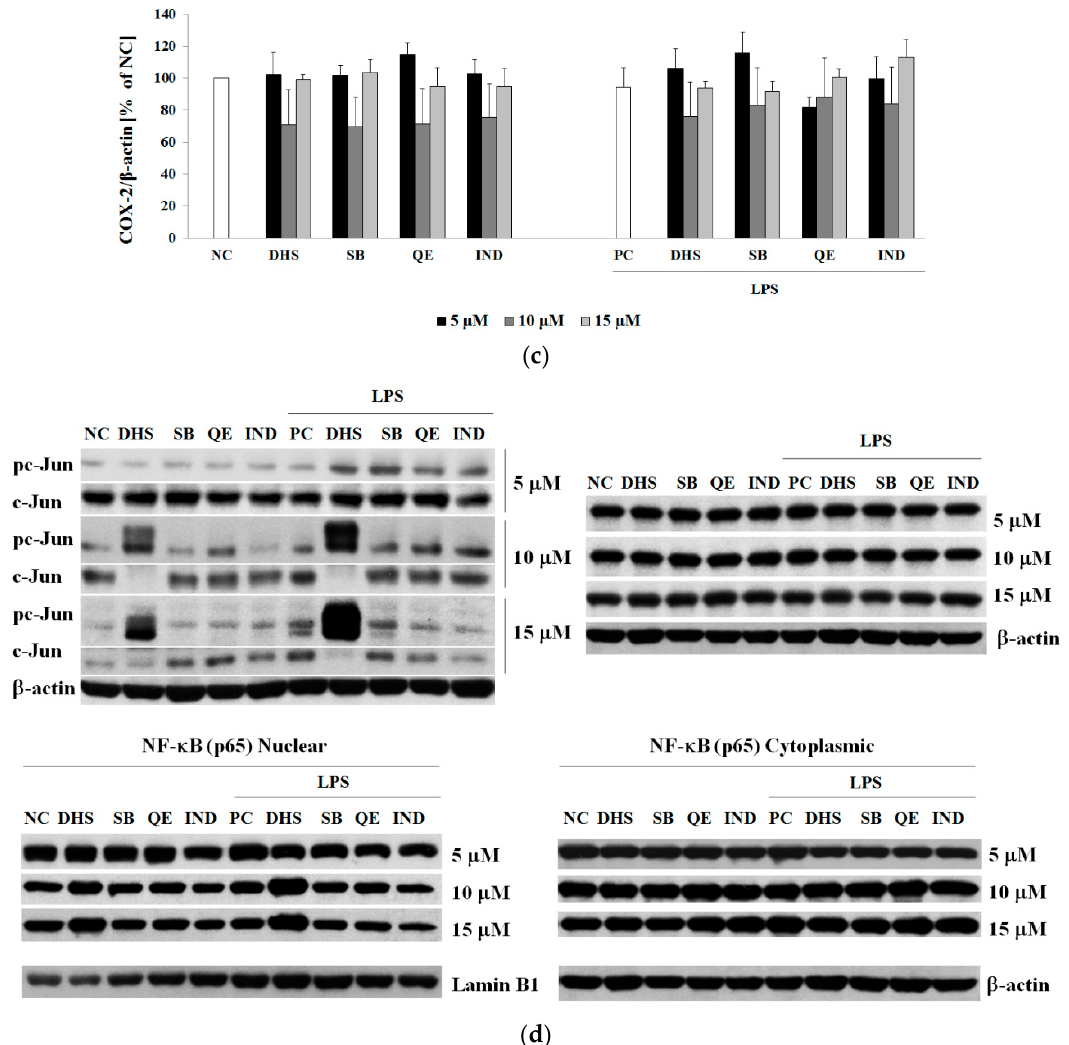
Figure 3. Evaluation of the selected silymarin components effect on transcription factor NF ‐κ B (subunit p65) nuclear translocation, transcription factor AP ‐ 1 activation (phosphorylation of subunit c ‐ Jun) and enzyme COX ‐ 2 protein levels with/without LPS pretreatment by densitometric analysis of Western blot bands. The analysis of transcription factors NF ‐κ B p65 ( a ) nuclear translocation or AP ‐ 1 activation via c ‐ Jun phosphorylation ( b ) or endogenous protein COX ‐ 2 expression ( c ) was performed on cytoplasmic/nuclear or whole ‐ cell lysates of NHDF. Following 6 h of pre ‐ incubation with or without LPS, NHDF were exposed to 5, 10 and 15 μ M QE, SB, DHS or IND for a further 24 h. Beta ‐ actin or Laminin B1 were used as a loading control, for whole ‐ cell and cytoplasmic or nuclear lysates, respectively. Data are presented as a mean percentage relative to NC ± SEM ( n = 5), significantly different from NC ( # p < 0.05; ## p < 0.01) or PC (* p < 0.05). NC: negative control (0.1% vehicle DMSO in serum ‐ free culture medium), PC: positive control (6 h of LPS stimulation followed by 24 h incubation with 0.1% vehicle DMSO in serum ‐ free culture medium); ( d ) Representative Western blot.